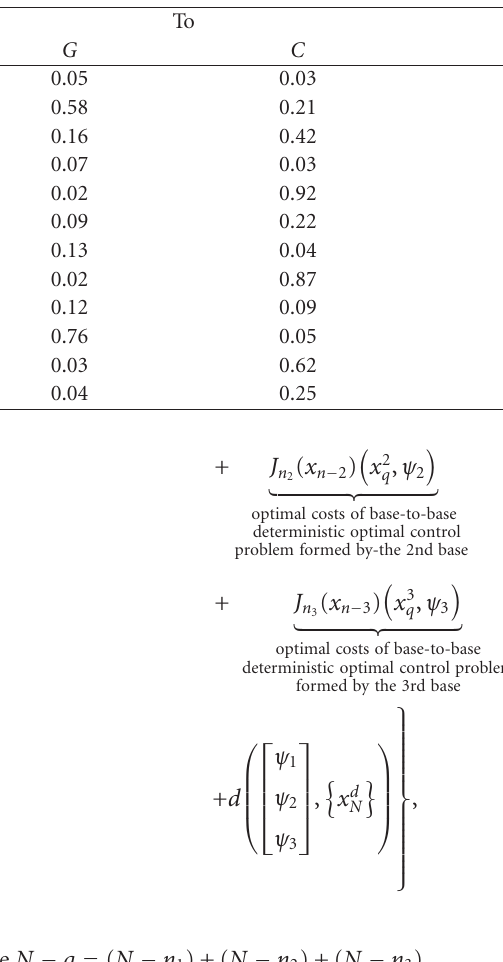
Table 12: Sample probabilities with respect to di ff erent mutagens and di ff erent transfer patterns. From Index ( l 1